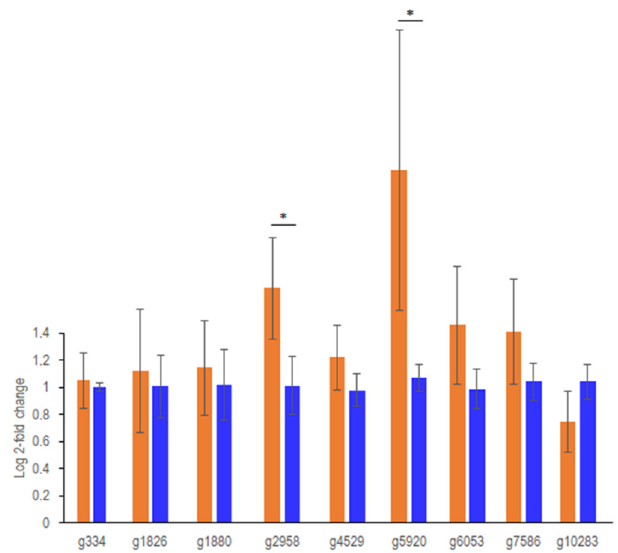
Figure 4. Expression of sesquiterpene synthases with log2-fold changes measured by qRT-PCR in T. vaccinum . Axenic (blue) and mycorrhiza with P. abies (orange) were measured. The gene identifiers for the nine genes, coding for putative sesquiterpene synthases, are given; n = 3. Statistical significance is indicated with a star.